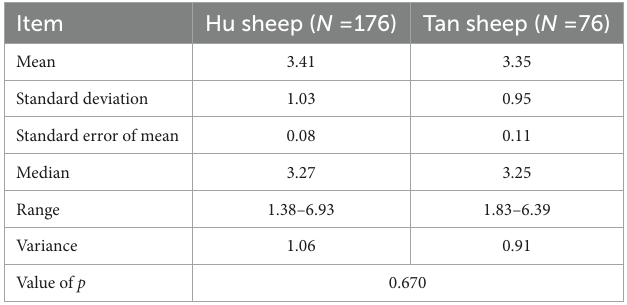
TABLE 1 Descriptive statistics of intramuscular fat content (IMF; % w / w ) in Hu and Tan sheep. Item